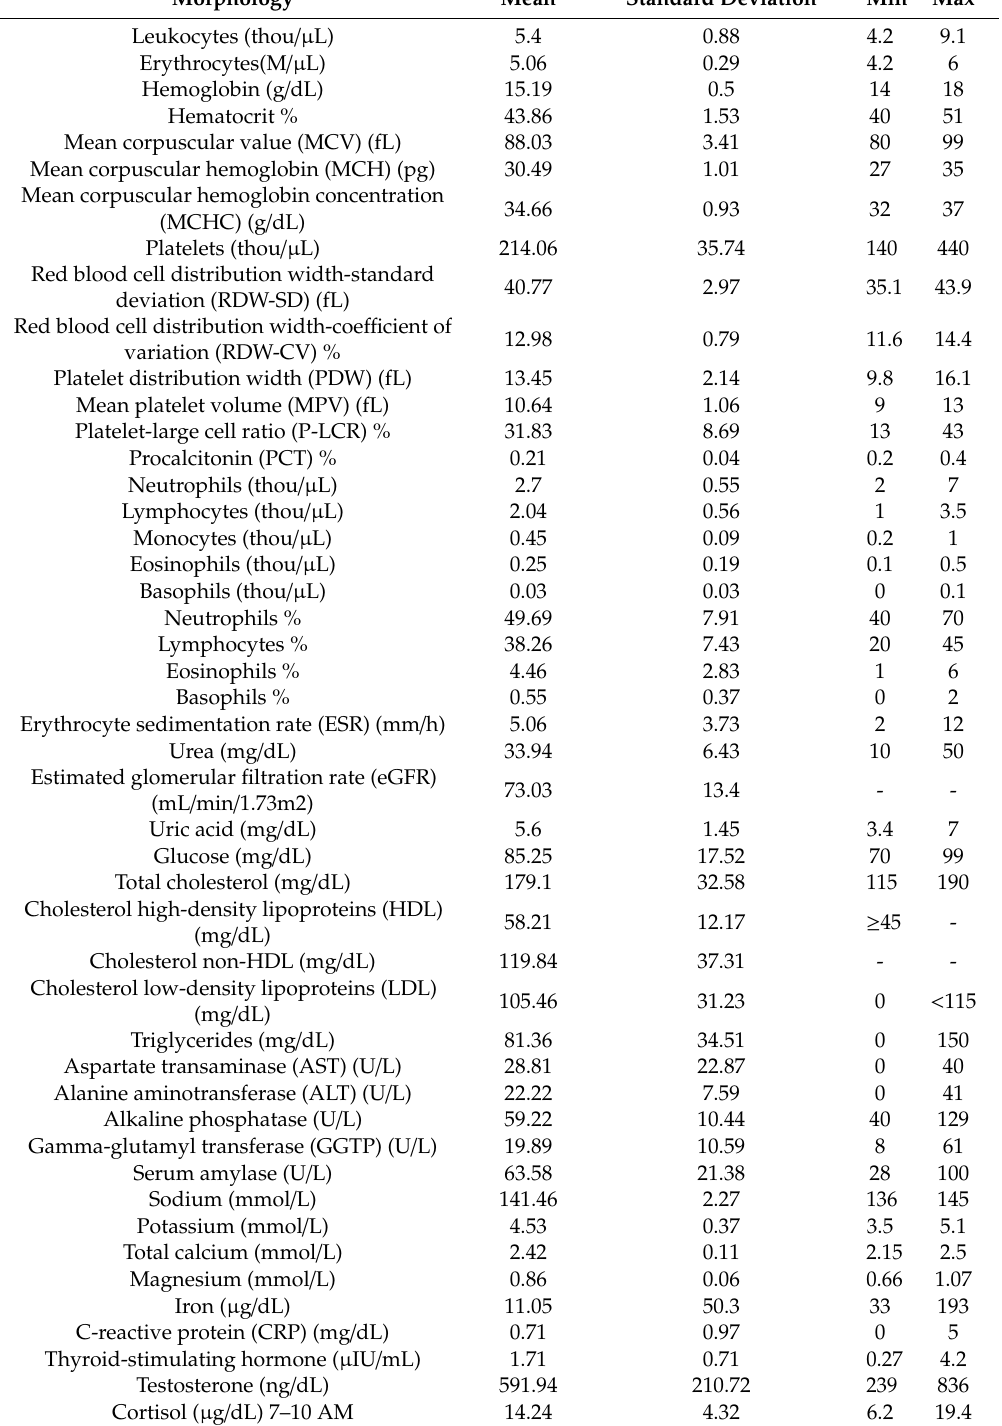
Table 3. Hematological parameters of